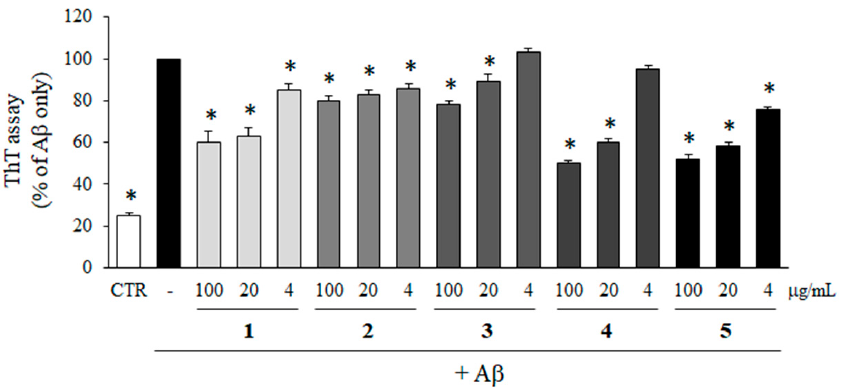
Figure 5. Activity of compounds 1 – 5 on the disaggregation of A β . Pre-aggregated A β in advance was incubated with 4, 20, and 100 µ g/mL of compounds 1 – 5 for 24 h. In case of control group, DMSO was added instead of test samples. The A β disaggregation was determined by ThT assay. All data represent the mean ± SD of three different experiments. * p < 0.05, significantly different from A β only group.